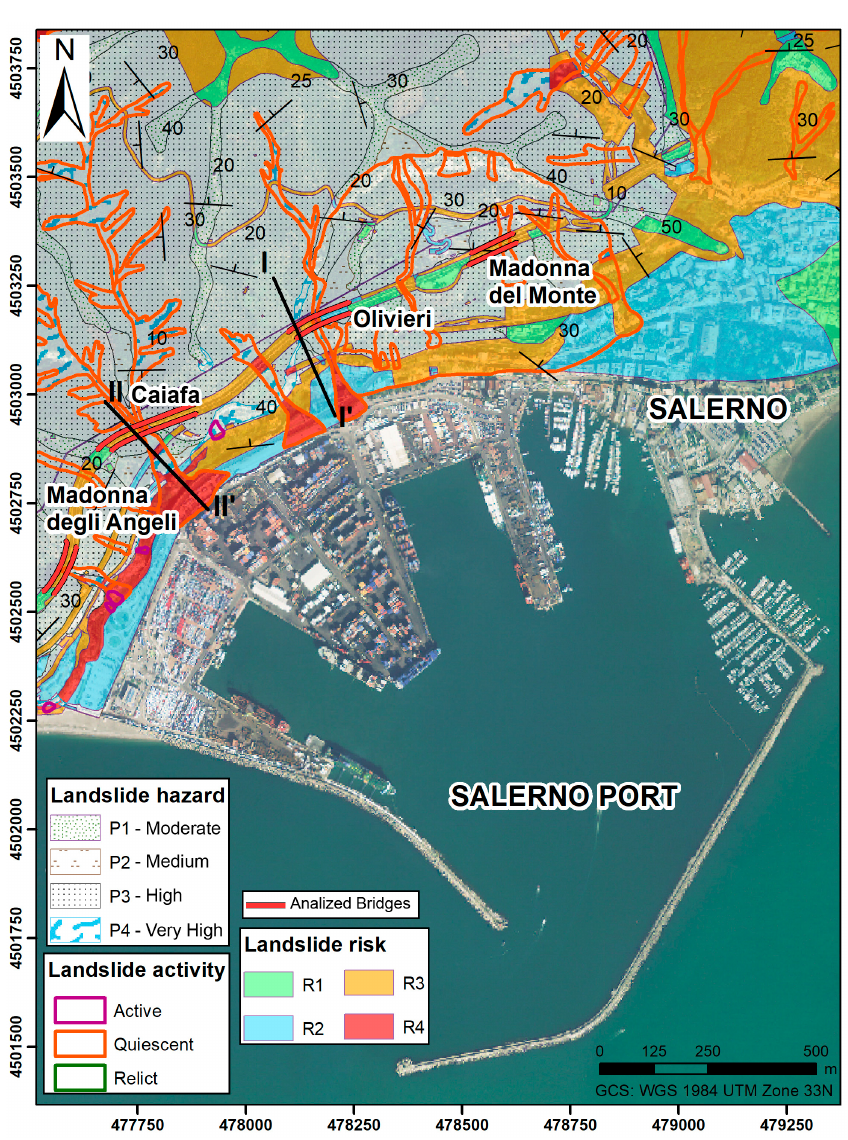
Figure 3. Landslide hazard, risk and activity map. This map has been drawn based on the maps available on the website [55]. available on the website